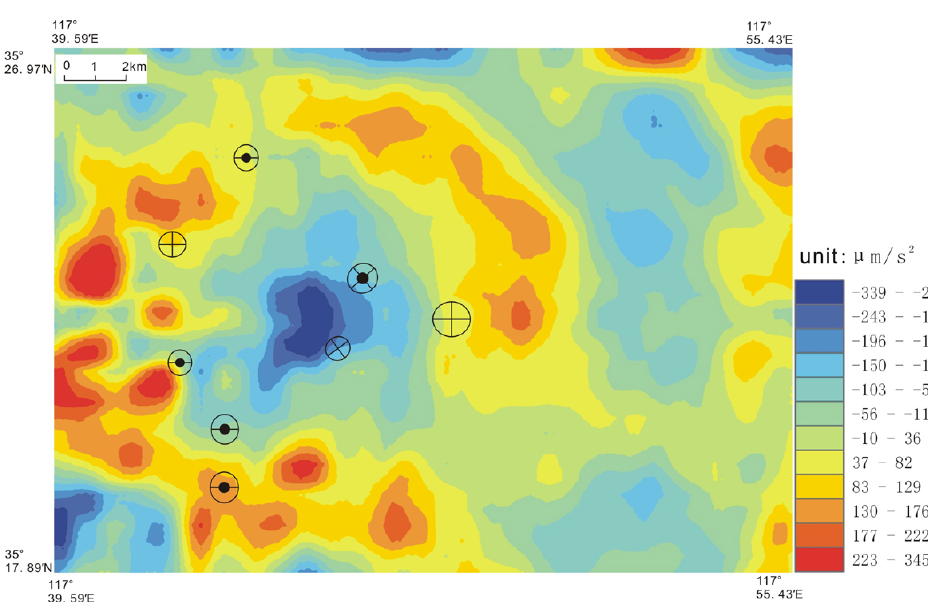
Fig. 5. Reconstructed image from the 3rd to 8th eigenimages. The legends for the gold deposits see in Fig. 1.